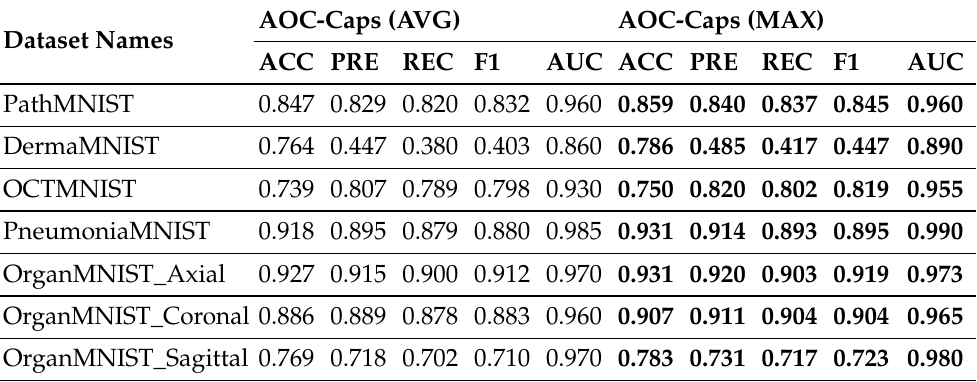
Table 10. Performance of different pooling operations in